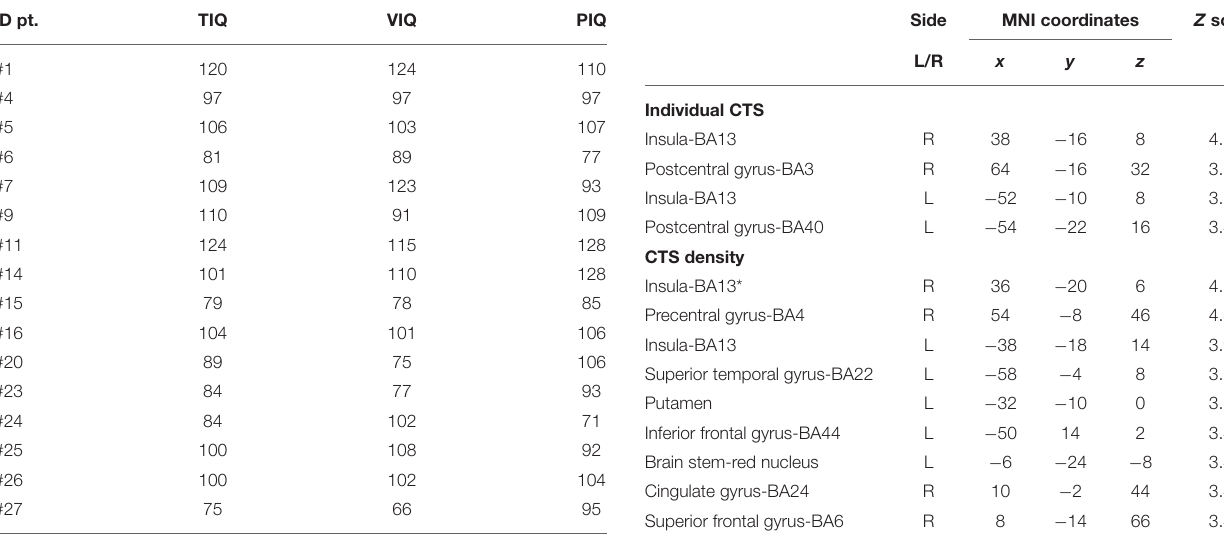
TABLE 2 | Neuropsychological measures of CECTS. TABLE 3 | Group level CTS-related BOLD